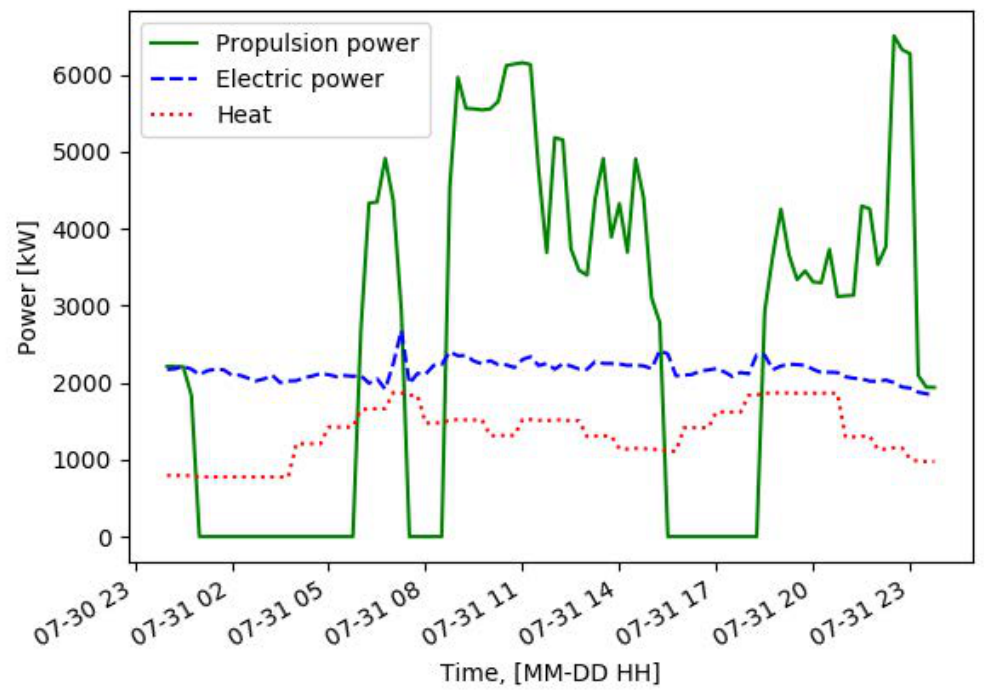
Figure 12. Energy demand during a day of operations, Summer (31